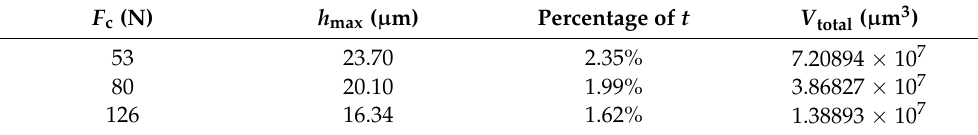
Table 3. Maximum wear depth and wear volume under different clamping forces.